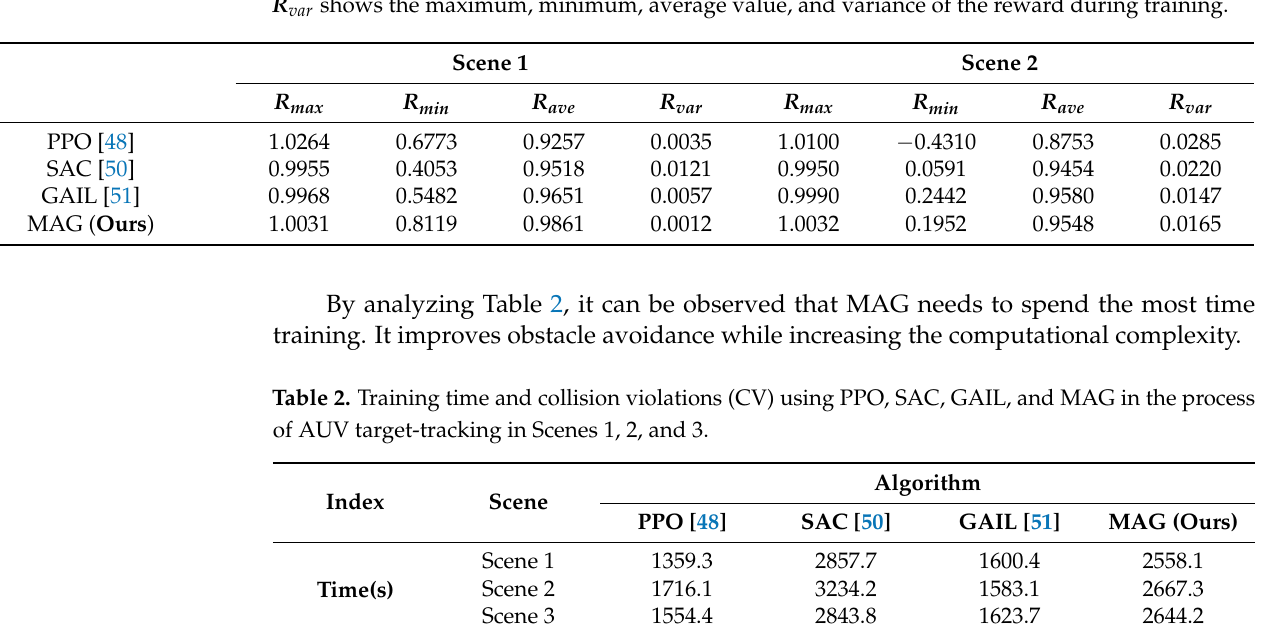
Table 1. Data analysis of total reward using four methods in Scenes 1 and 2; R max , R min , R ave and R var shows the maximum, minimum, average value, and variance of the reward during training.